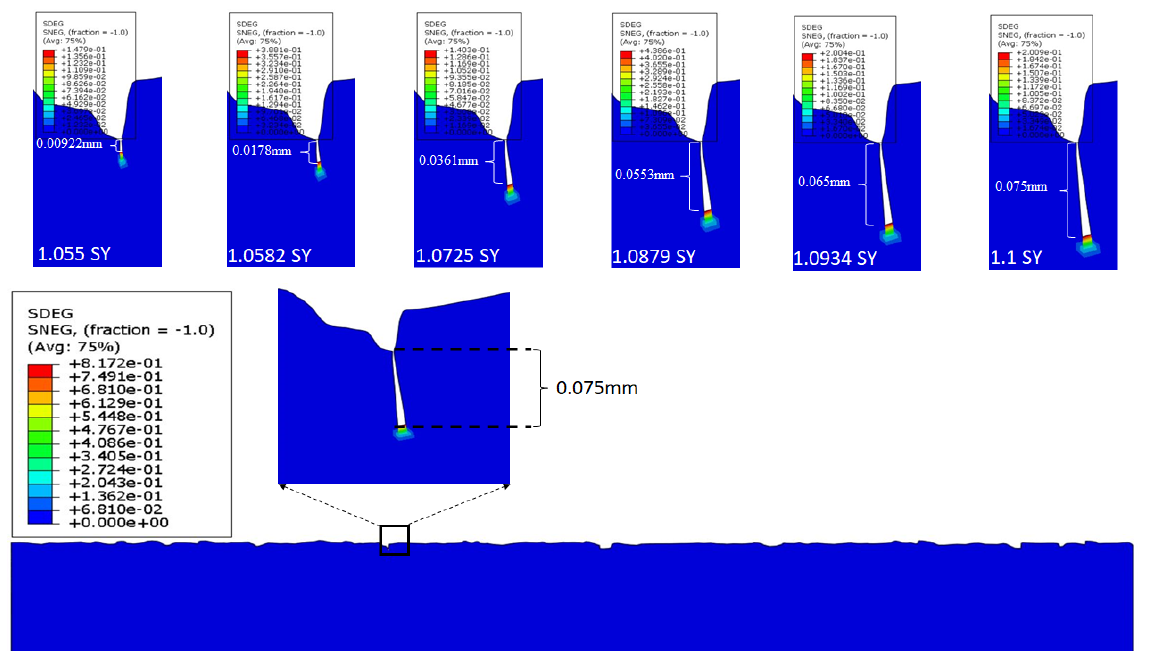
Figure 6. Damage initiation, evolution and crack formation for the most critical micro-notch at the surface without residual effect.